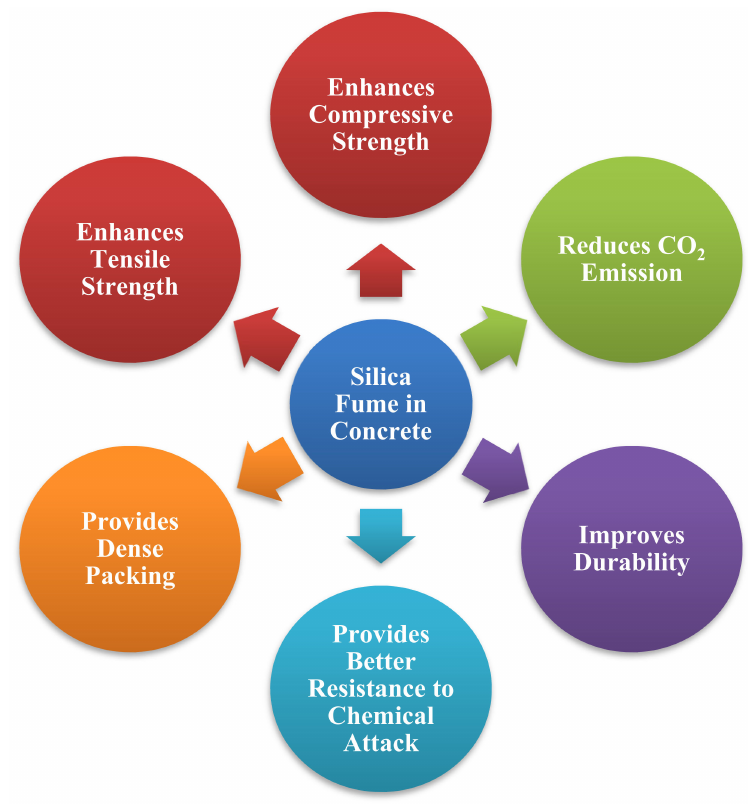
Figure 1. Silica fume benefits in